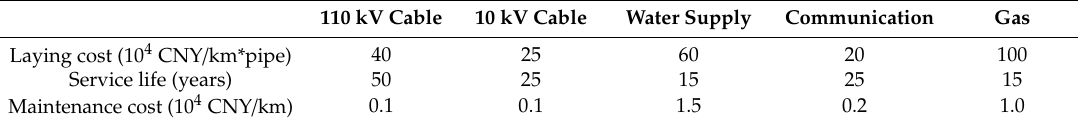
Table 3. Cost-sharing of pipeline companies (Unit: 10 4 CNY).